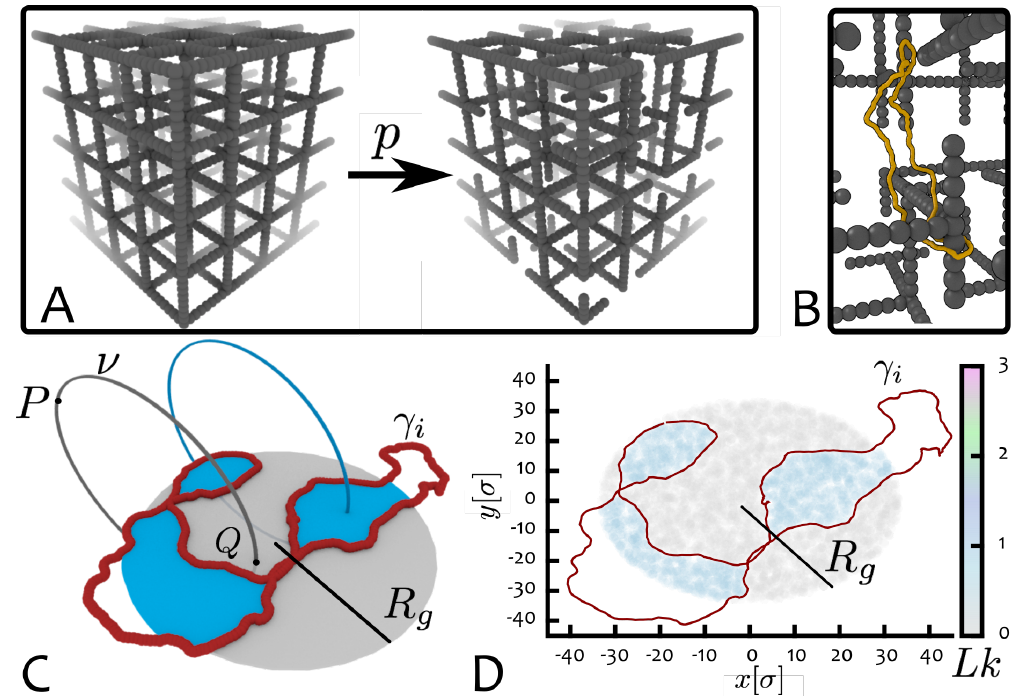
Figure 4. Quantifying impalements of rings with disordered gels. ( A ) An agarose gel is modelled as an imperfect cubic lattice where half-edges are removed with probability p . This disordered gel is constructed in such a way it possesses dangling ends [26,29] (adapted from Reference [32]). ( B ) Dangling ends can trap migrating rings (by forming impalements). ( C ) Equilibrated ring configurations γ i (for ring polymer i in red) are projected onto a plane and the area corresponding to a disk of radius R g sampled using virtual closed paths ν (grey). These paths (grey and blue) start from different points P far away from the projections and pierce the disk once at different locations Q either linking (blue) or not (grey) with the ring projection. ( D ) The average piercing number (cid:104) π (cid:105) is then computed averaging the value of the linking number, Lk ( x , y ; γ i , ν ) (shown as density map in the figure), over different projections of γ i and sampling different virtual paths ν over the area of the disk (adapted from Reference [31]). The average piercing number gives an estimation of how likely an entanglement between the ring and a dangling end